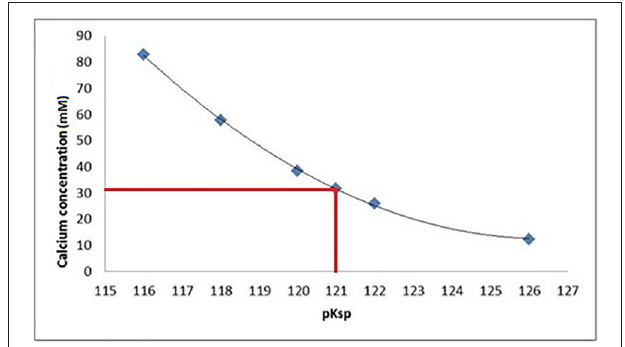
FIGURE 7 | At a pKsp of 121, a calcium concentration of 30mM is required for saturation of a solution with respect to HAp at pH = 4.0.